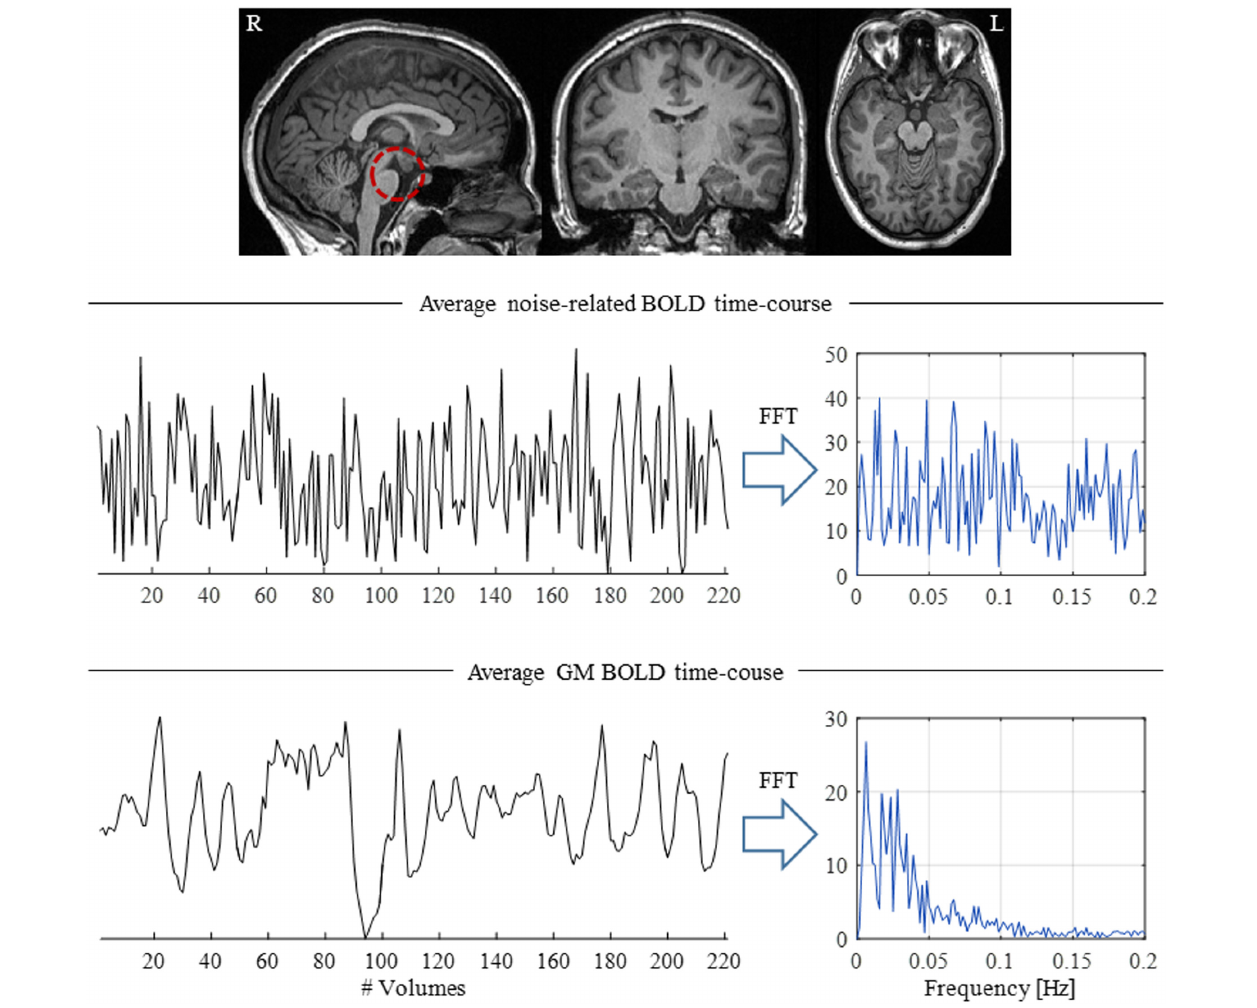
FIGURE 4 | Illustration of the presence of physiological-related fluctuations in the BOLD signal. (Top) Structural brain image highlighting the brainstem (red dashed circle), a brain structure located close to major arteries and CSF-filled spaces, thus particularly susceptible to physiological fluctuations. (Middle) Average physiological noise-related BOLD time-course and respective power spectrum computed from a region near the brainstem. (Bottom) Average BOLD time-course across GM; in contrast with the brainstem, the GM time-course presents a clear 1 f spectrum, with most of its power located at frequencies below 0.1